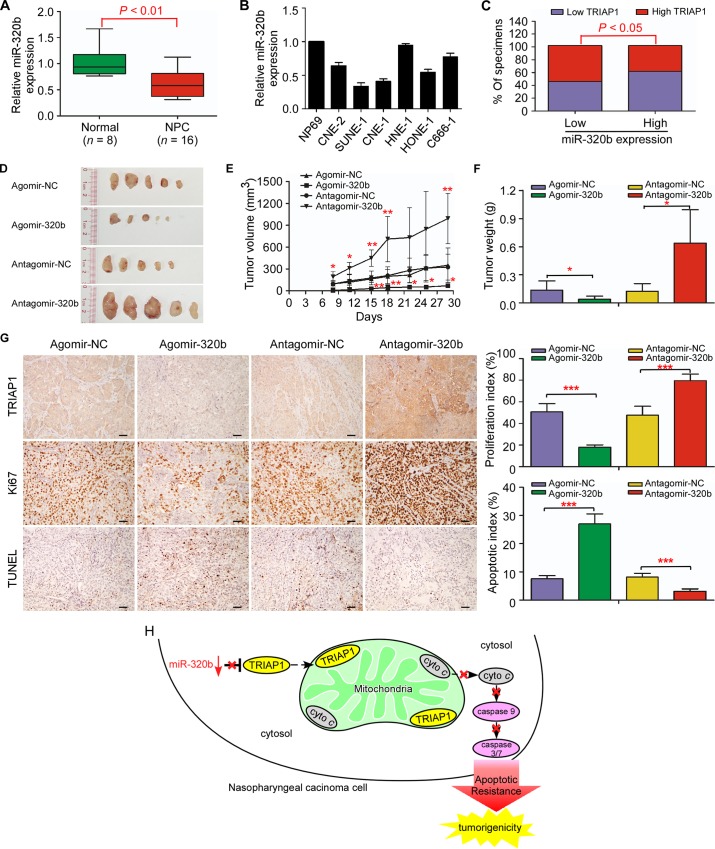
Loss of miR-320b is associated with TRIAP1 overexpression and tumor growth in NPC.A and B, quantitative RT-PCR analysis of miR-320b expression in normal nasopharyngeal epithelial tissues (n = 8) and NPC (n = 16) (A); and in immortalized NP69 cells and NPC cell lines (B). U6 was used as an endogenous control. Each experiment was independently repeated at least three times. The data are presented as the mean ± s.d. Student’s t-test. C, percentages of specimens showing low or high miR-320b expression relative to TRIAP1 expression level. Statistical significance was determined using the Pearson’s Chi-Square test. (D-G) SUNE-1 cells were subcutaneously injected into the dorsal flank of nude mice after pre-transfected with agomir-320b, antagomir-320b or NC control (100nM). Intratumoral injection of agomir-320b, antagomir-320b or NC control was performed after tumor formation. (D-F) Representative images (D), tumor volume growth curves (E) and weight (F) of tumors developed in xenograft models injected with agomir-320b, antagomir-320b or NC control. (G) Representative images (left panel) and quantification of the percentage (right panel) of Ki67-positive and TUNEL-positive cells in xenografts. Scale bar, 50 μm. The data are presented as the mean ± s.d. Student’s t-test, * P < 0.05, ** P < 0.01, *** P < 0.01. H, proposed model. Downregulated miR-320b determined TRIAP1 overexpression to prevent mitochondrial fragmentation and cytochrome c release into the cytosol, leading to apoptosis resistance and tumorigenesis in NPC.